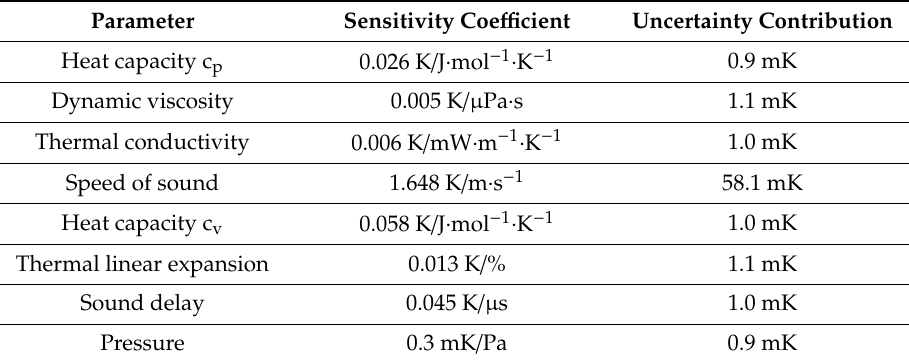
Table 3. Results of Monte Carlo (MC)